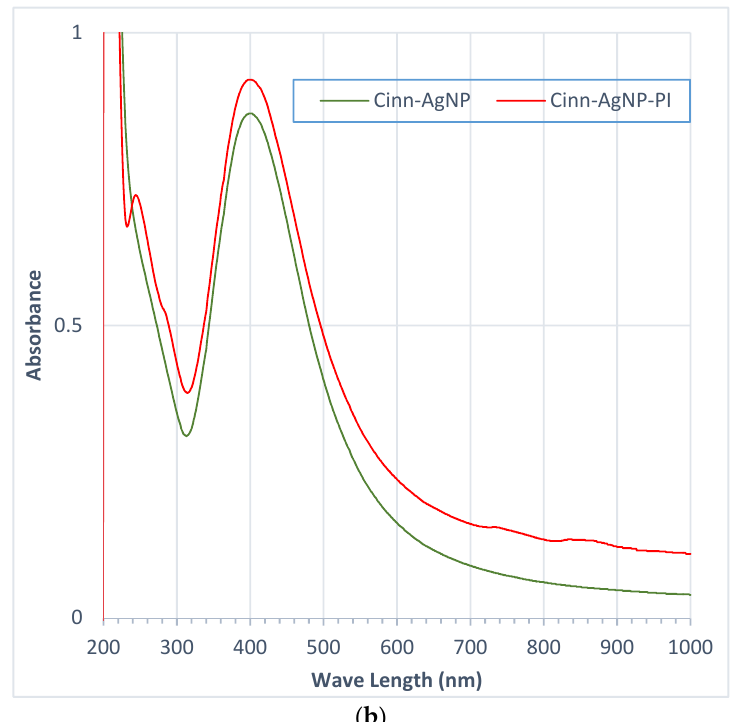
Figure 6. Ultraviolet-visible (UV-vis) spectrometric analysis of the four samples. From up to down: ( a ) TCA-AgNP and TCA-AgNP-PI; ( b ) Cinn-AgNP and Cinn-AgNP-PI.